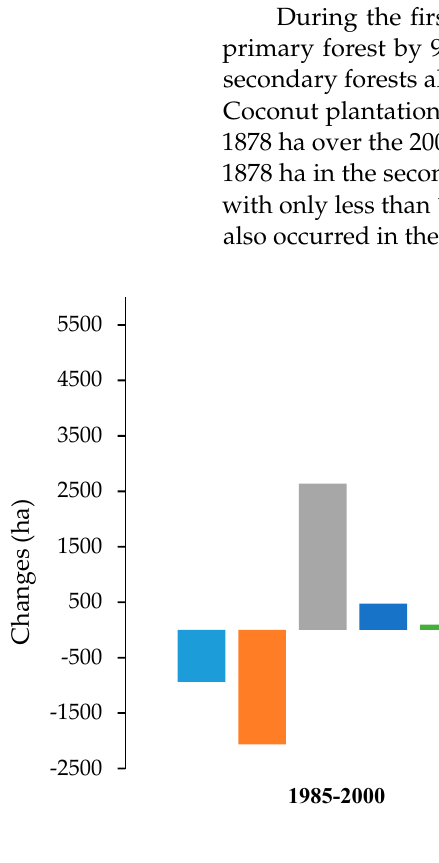
Figure 4. Increase (positive change) and decrease (negative change) in the area of each type of land cover in ATPF during the period 1985–2000 and 2000–2020.